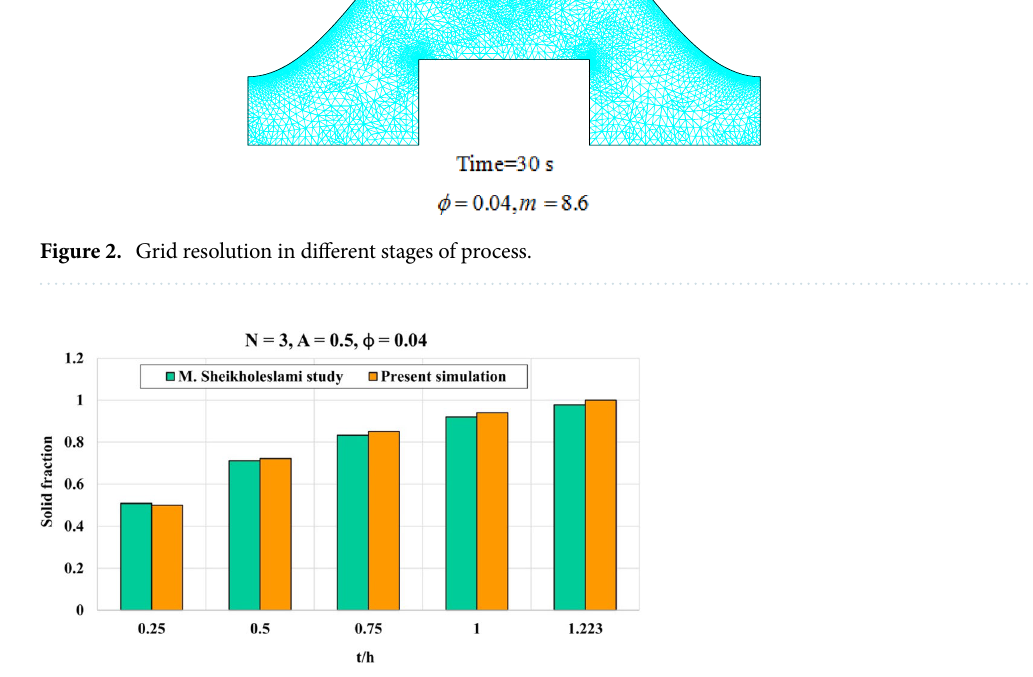
Figure 3. Evaluation of correctness of simulation 53